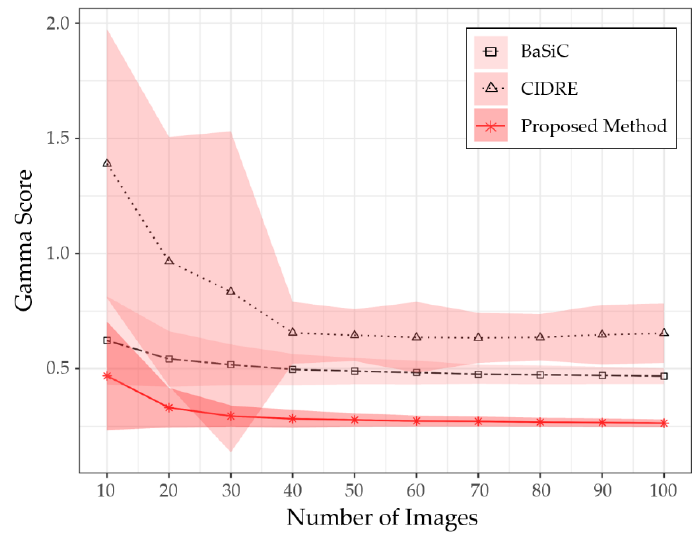
Figure 7. Comparison of gamma scores for number of input images.